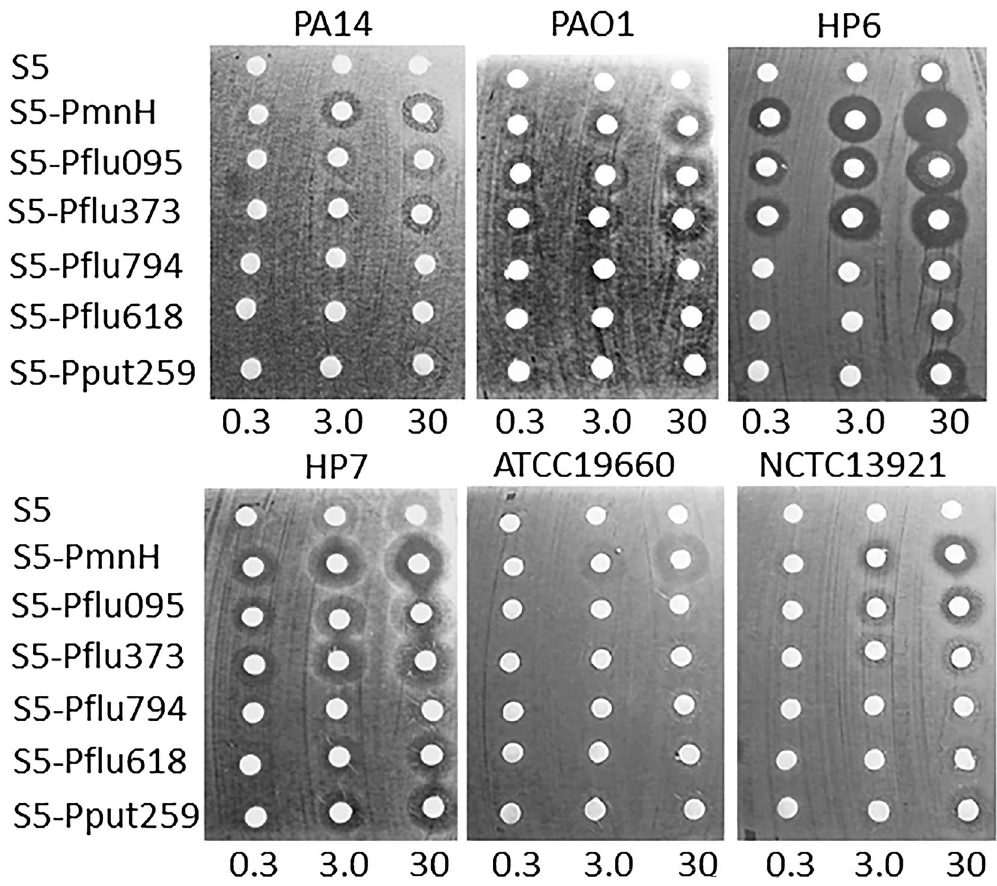
Figure 3. Pyocin S5 and chimeric pyocin activities on pyocin S5-producing P. aeruginosa strains. 0.3, 3 and 30 μg of S5 and chimeric bacteriocins were spotted on 6 mm Whatman discs placed on CAA agar lawns of different P. aeruginosa strains and incubated overnight.